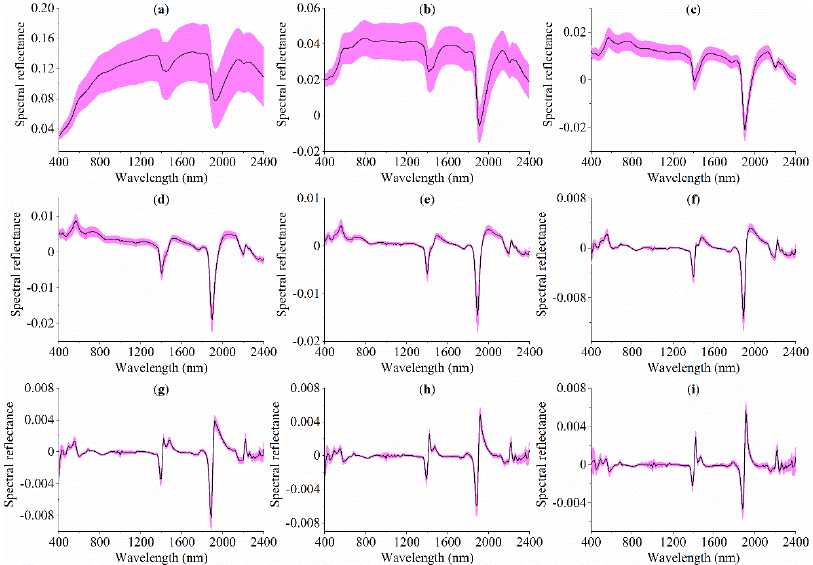
Figure 4. Mean fractional order derivative (FOD) spectra of moist soil samples ( n = 91): ( a ) original reflectance (order = 0); ( b ) 0.25-order; ( c ) 0.5-order; ( d ) 0.75-order; ( e ) 1-order; ( f ) 1.25-order; ( g )